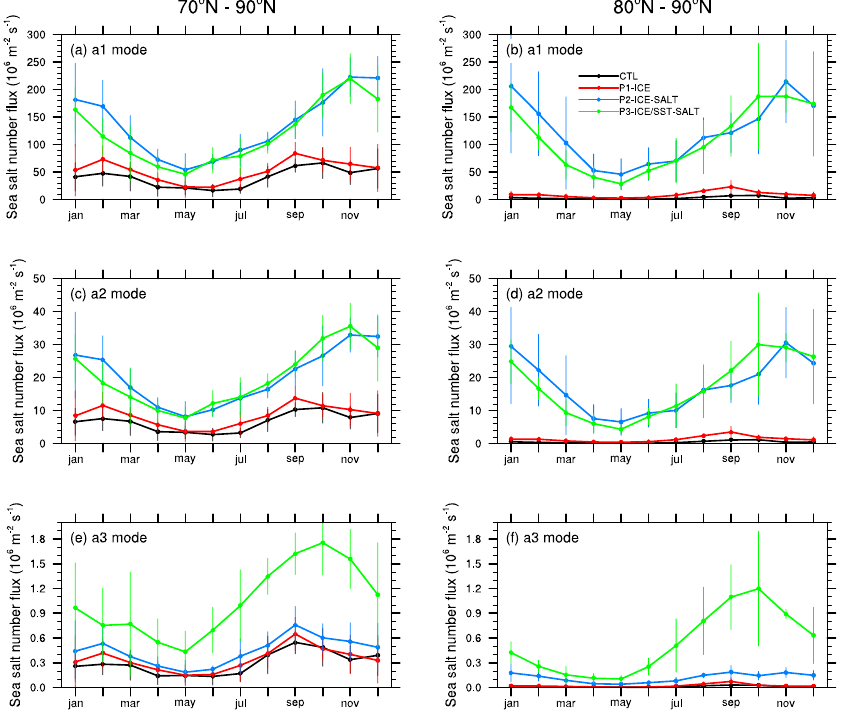
Fig. 7. Average (ocean grid points only) Arctic sea salt surface emission fluxes (10 6 m − 2 s − 1 ) for the three sea salt aerosol modes used CAM-Oslo (see Table 1). Values are averages over the final five years of the model integrations. Vertical lines indicate the two standard deviations corresponding to the monthly